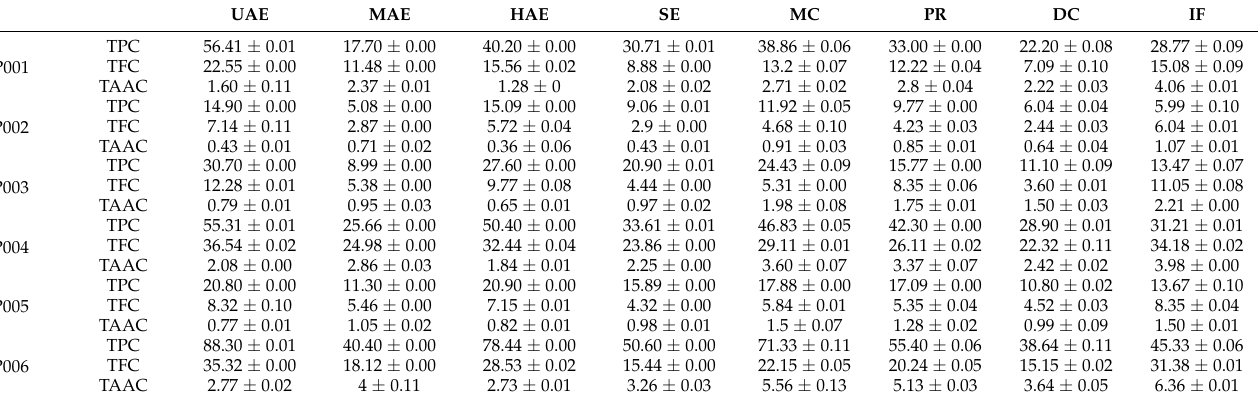
Table 1. Total polyphenol contents in MAPs extracted with different extraction